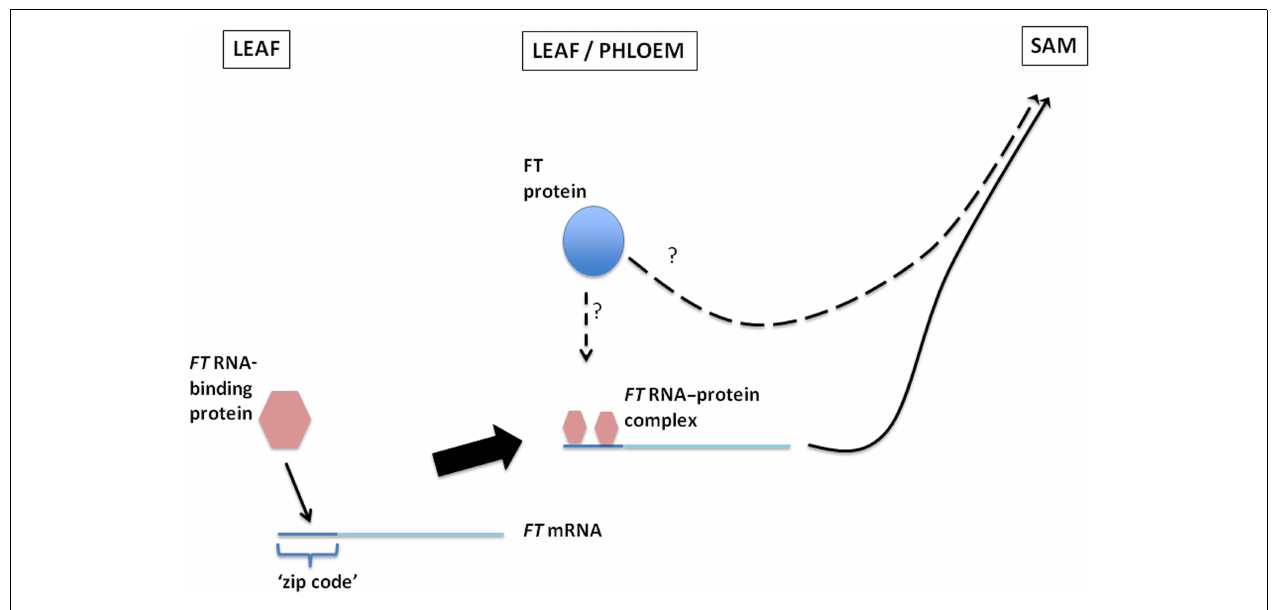
associate, and be transported, with this RNA–protein complex, or it may move independently of the FT mRNA with its movement through the plasmodesmata and into the SAM being facilitated by the FT RNA–protein